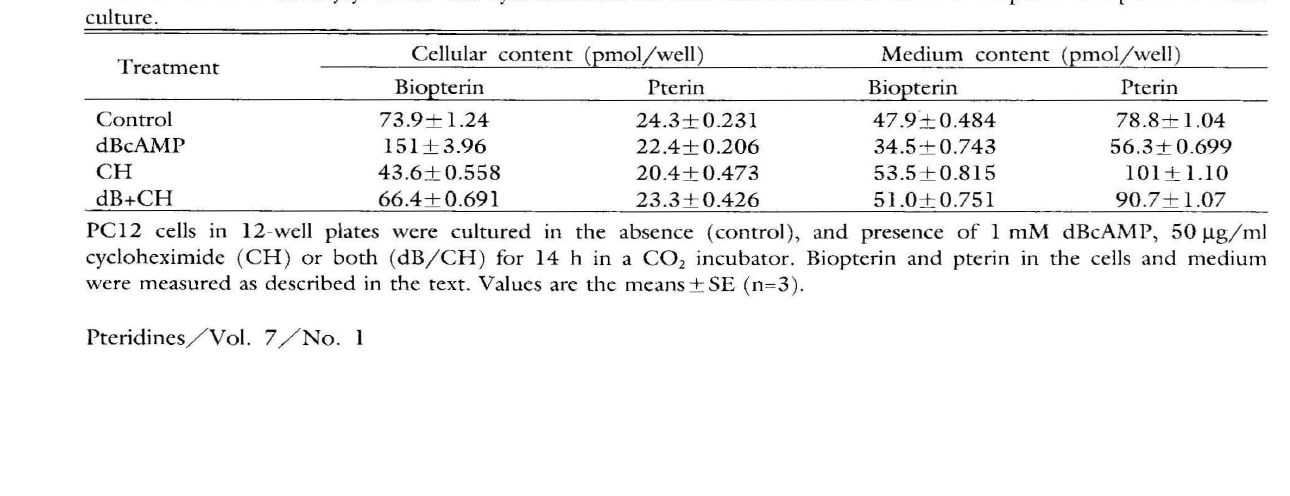
Table I . Effect of dubutyryl cAMP and cycloheximide on intra and extracellular levels of biopterin and pterin in PC 12 culture.